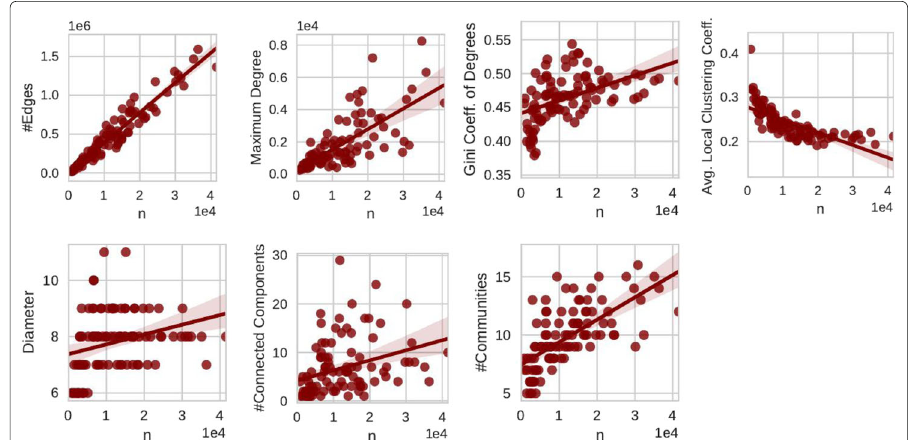
Fig. 1 Scaling behavior of 100 Facebook networks; from left to right and top to bottom: number of edges, maximum degree, Gini coefficient of degree distribution, average local clustering coefficient, diameter, number of components, number of communities found by Parallel Louvain